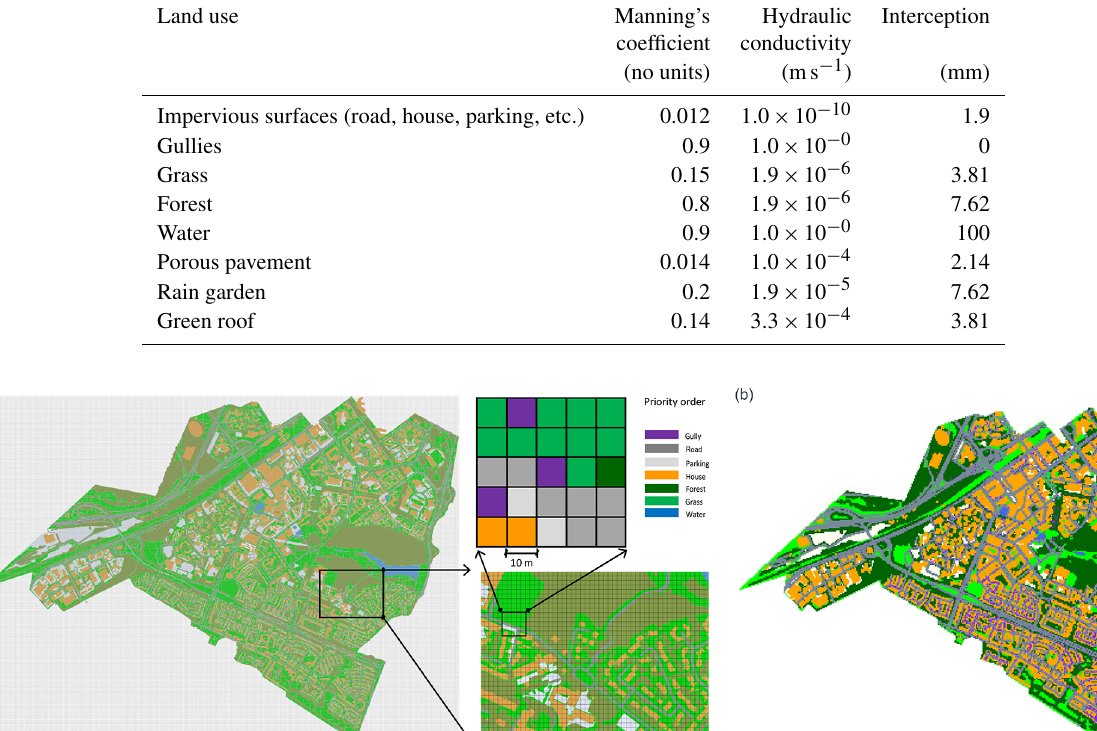
Figure 5. (a) Rasterization of the original land use data into 10m with priority order and (b) the rasterized land use data.